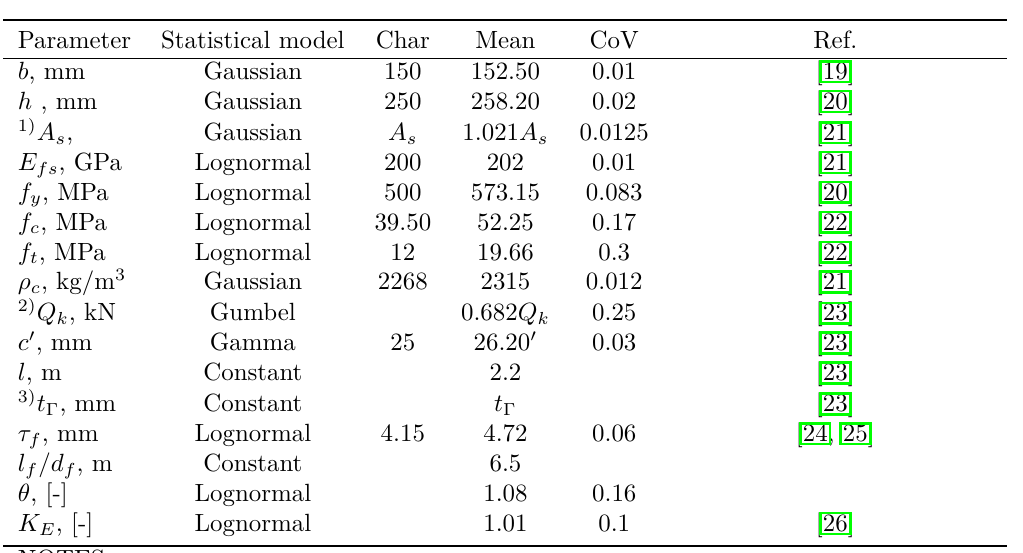
Table 1. Statistics of stochastic parameters in the load, geometric, and resistance models